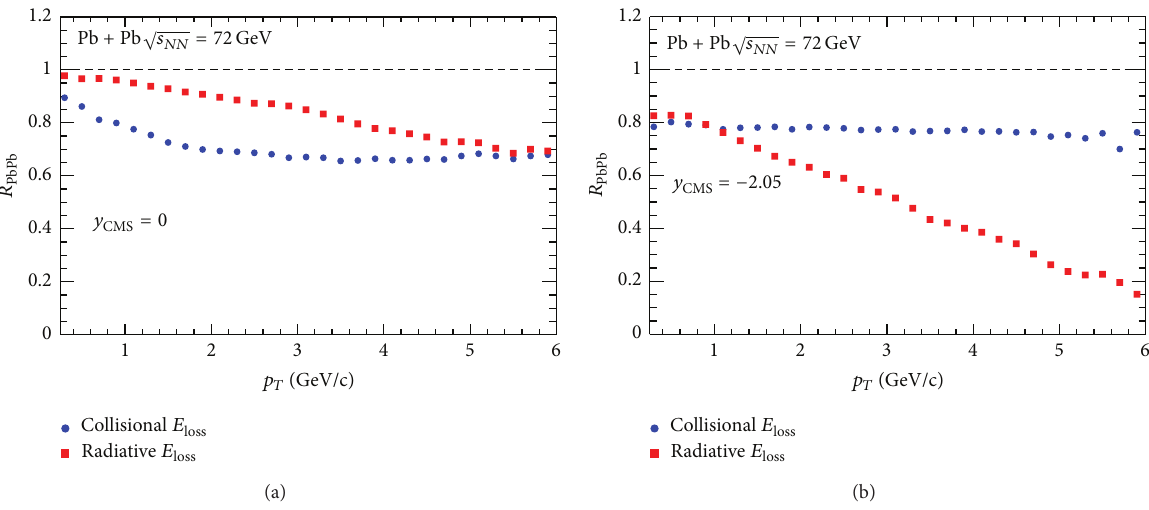
Figure 6: Nuclear modification factor 𝑅 𝐴𝐴 (central value) for charm quark in Pb + Pb collisions at √ 𝑠 𝑁𝑁 = 72 GeV at midrapidity ( 𝑦 CMS = 0) and forward rapidity ( 𝑦 CMS = − 2 . 05) for a radiative and collisional energy loss from Figure 5. (Figure 6(b)) for 0–10% most central Pb + Pb collisions expected for 𝑑𝐸/𝑑𝑥 coll and 𝑑𝐸/𝑑𝑥 rad shown in Figure 5.